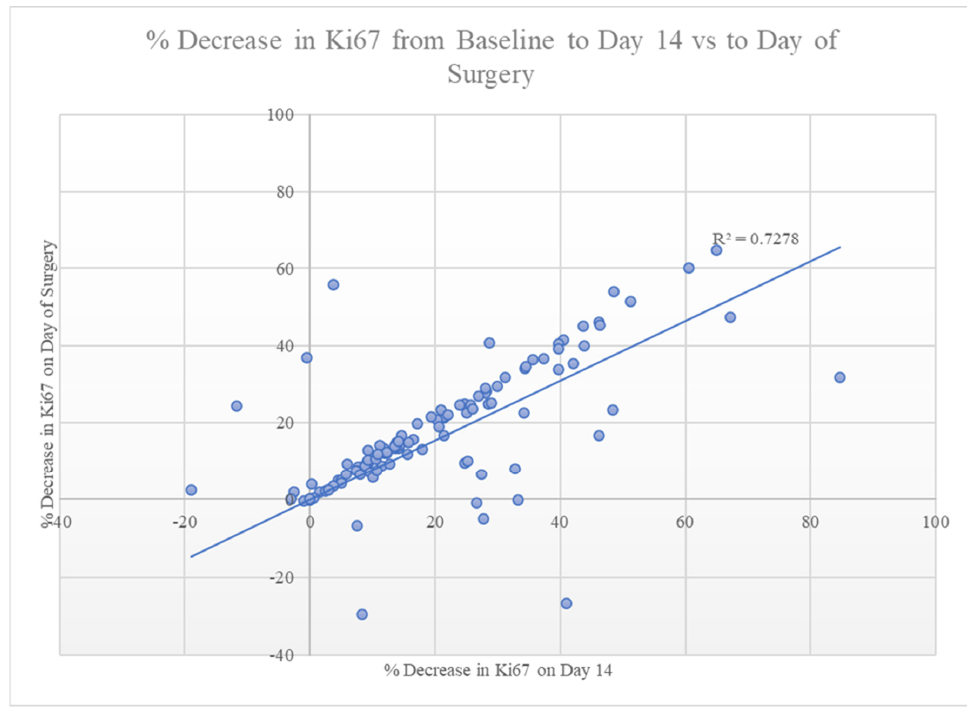
Figure 2. Correlation between the change in Ki–67 from baseline to day 14 versus baseline to the day of surgery, demonstrating a robust correlation between the two measurements ( p <